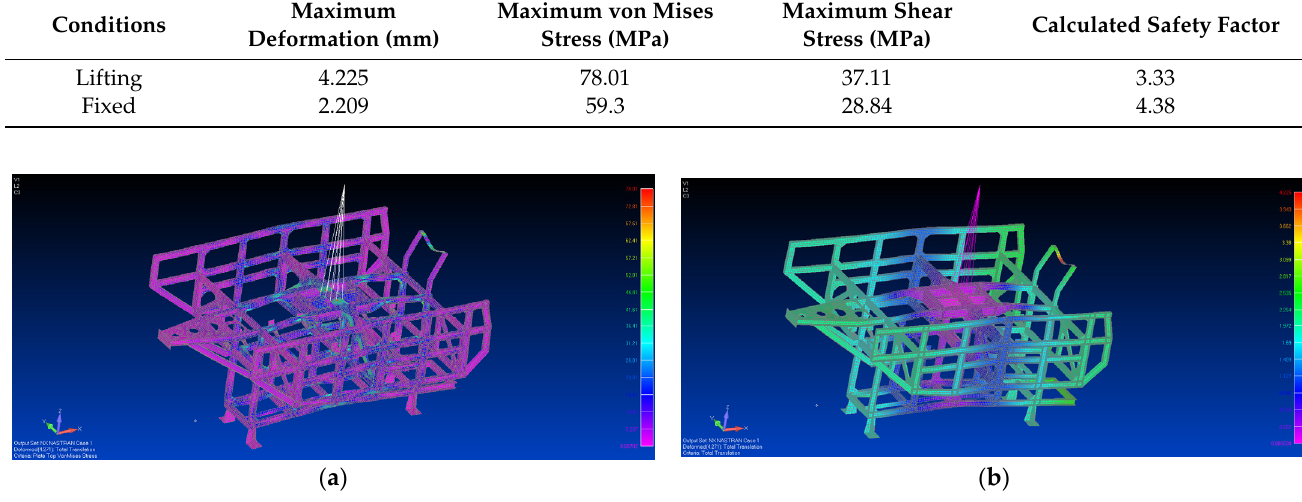
Figure 8. ( a ) The von Mises stress cloud map for lifting conditions; ( b ) the structural deformation cloud map for lifting conditions.